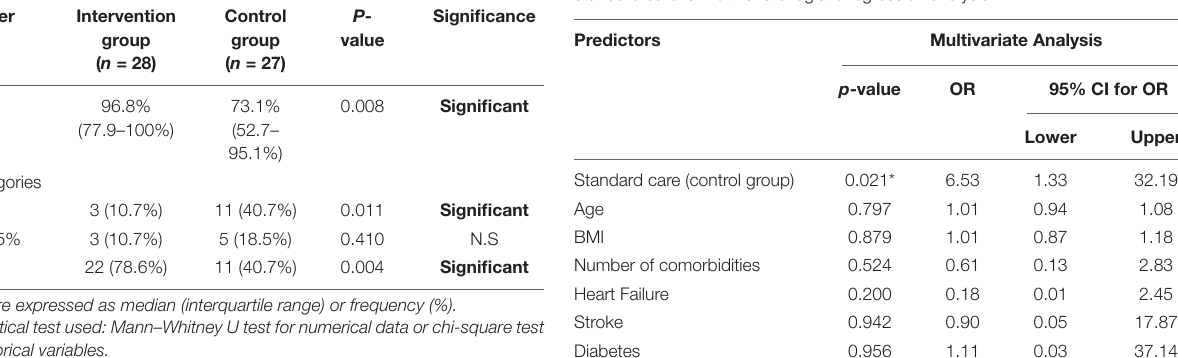
TABLE 3 | TTR outcomes at the end of the follow-up period. TABLE 4 | Risk of poor quality of anticoagulation (TTR < 65%) associated with standard care: a multivariate logistic regression